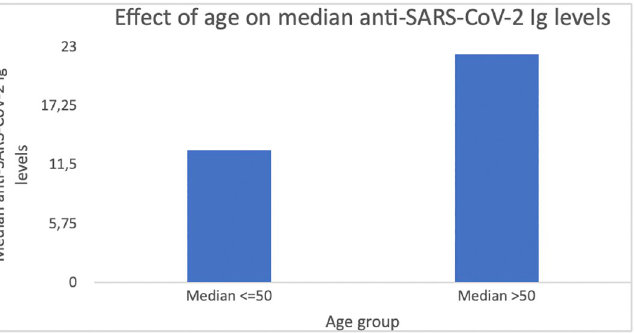
Fig 2. Effect of age on median anti-SARS-CoV-2 Ig levels. Significantly higher median anti-SARS-CoV-2 Ig level was found in the individuals > 50 years old when compared to the younger group (25.9; IQR 59.00 vs 16.00, IQR 36.00; U = 2535473.00; p < 0.001).